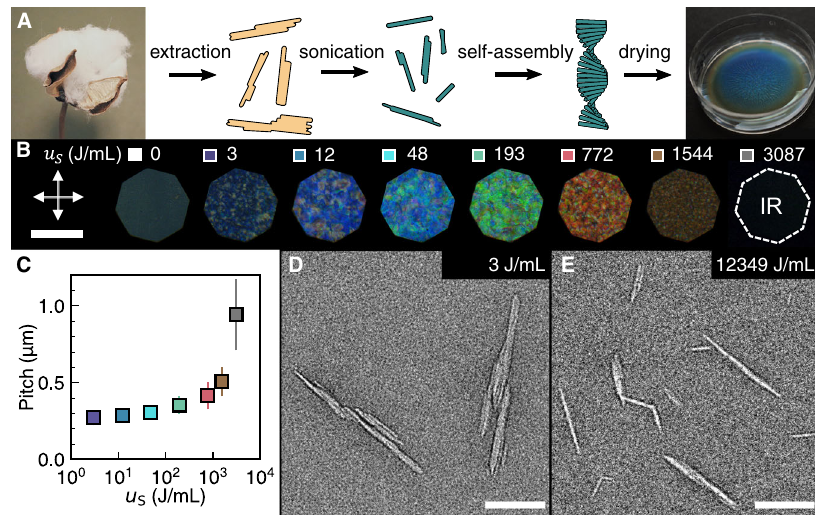
Fig. 1 Tuning the colour of photonic CNC fi lms with sonication. A Formation of structurally coloured fi lms via chiral self-assembly of CNCs extracted from cotton. Petri dish size 35 mm. Cotton image source 49 : B Photonic CNC fi lms of increasing sonication dose ( u s ), as viewed under crossed polarisers. Square panels next to each dose value indicate the colour code used for other plots. IR infrared. Scale bar 100 μ m. C Pitch increase with sonication dose, as inferred from cross-sectional scanning electron microscopy. Error bars indicate standard deviation of 30 measurements. D , E Examples of TEM images of CNCs, showing their composite morphology. Scale bar 100